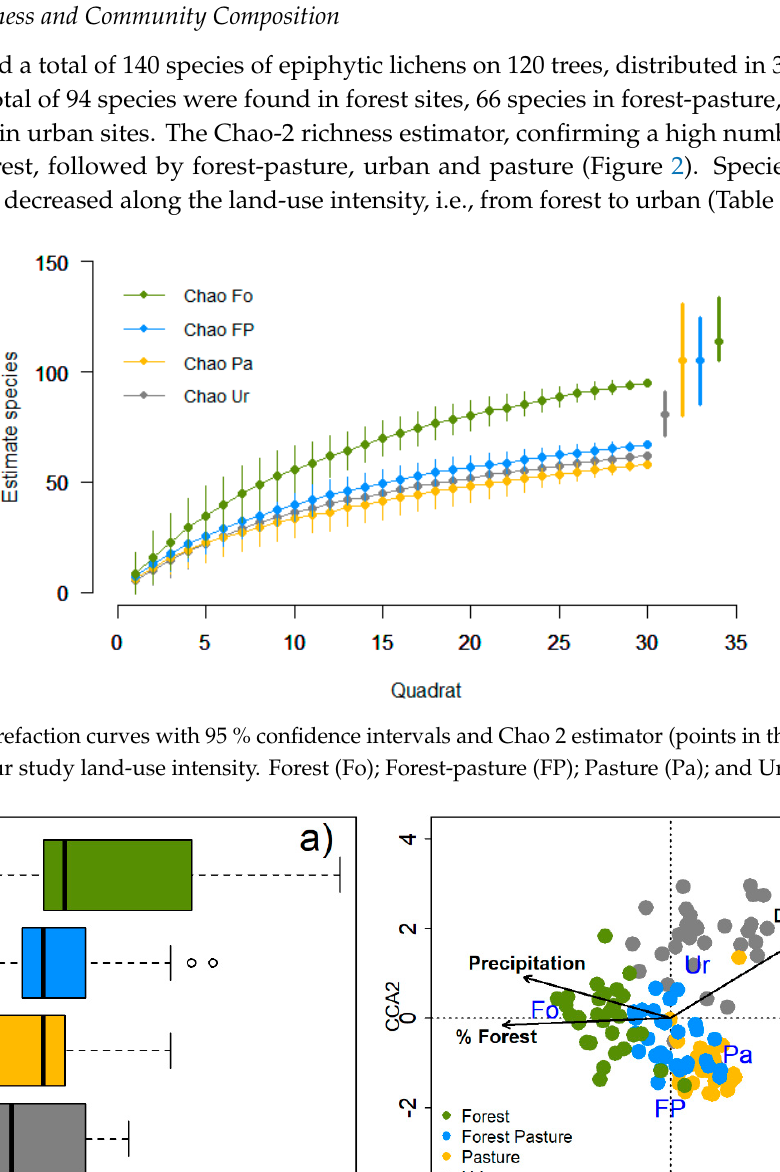
Figure 3. ( a ) Variation in species richness of epiphytic lichens in four riparian land uses of Andean streams in southern Ecuador. ( b ) CCA ordination plot of the lichen community using abundance data per tree and land-use intensity (covariate) precipitation, distance to forest and percentage of forest (predictors). Fo = Forest, FP = Forest Pasture, Pa = Pasture, Ur = Urban.